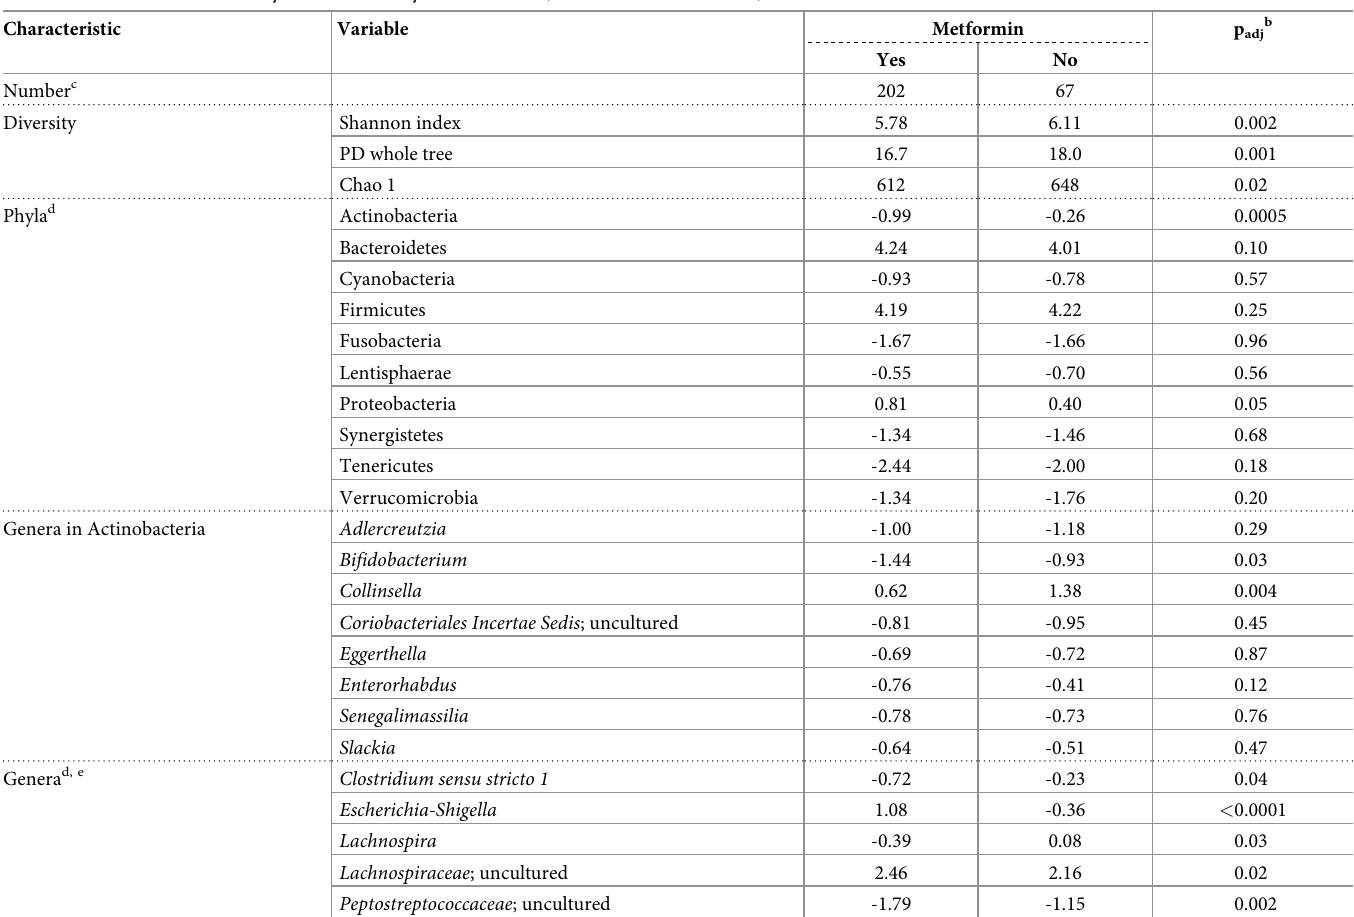
Table 3. Fecal microbial diversity and structure by metformin use, APS members with T2D, 2013–2016 a .